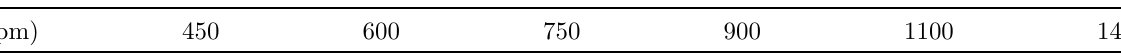
Table 3. Rotational speeds imposed on the camshaft.